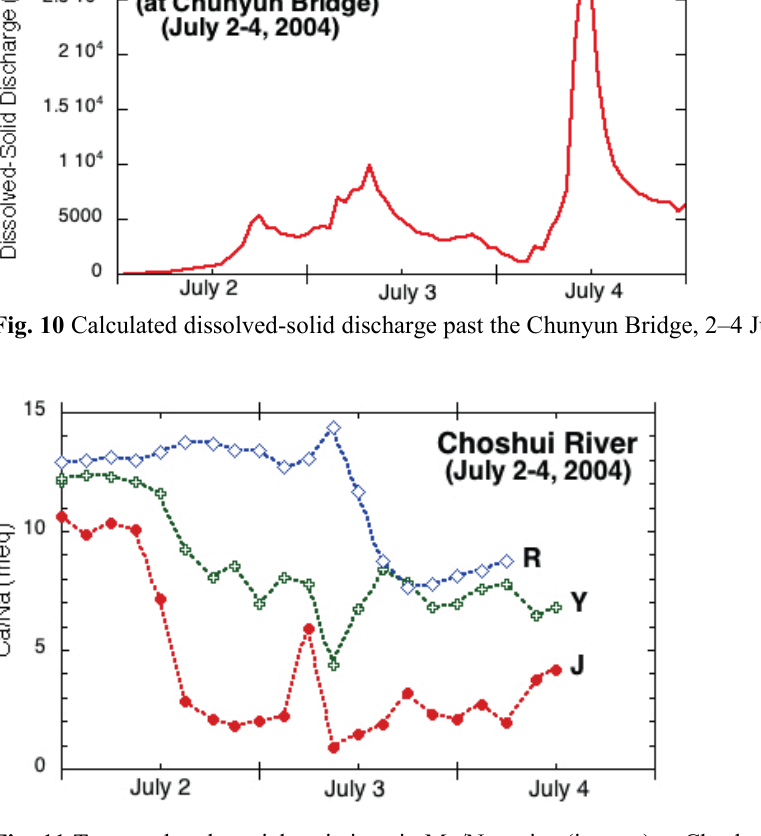
Fig. 11 Temporal and spatial variations in Mg/Na ratios (in meq) at Choshui River stations R, Y and J, 2–4 July